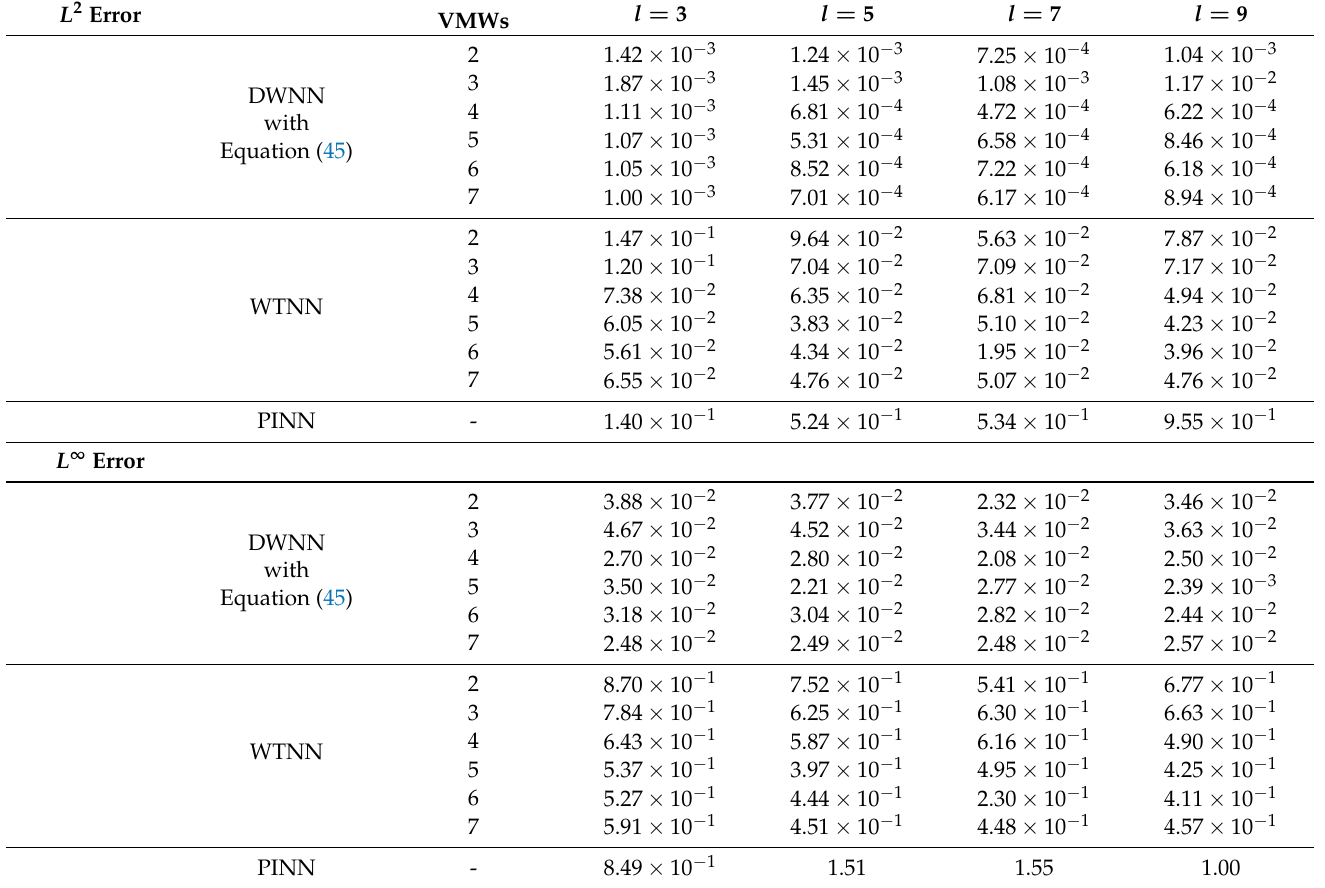
Table 6. The L 2 errors and L ∞ errors for 1D